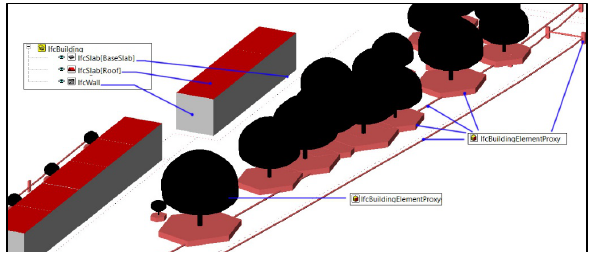
Figure 9. Resulting IFC